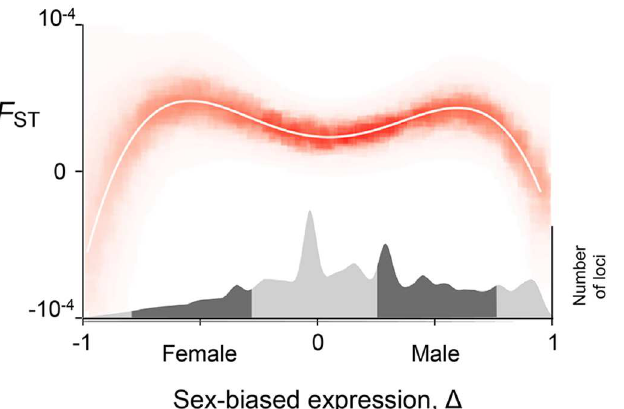
Fig 1. The strengthof sex-specific selectionis strongest on humanautosomal geneswith intermediatesex-biasedexpression. The white curve is the best-fit4 th degree polynomial and the intensity of red indicatesthe likelihood that the regression passes througha given value. The average F ST for the SNPs in a gene is small at Δ = 0 (unbiased expression), increasesto a peak as sex-bias grows, then decreases as Δ approaches–1 and 1. The numbers of genes with a given bias are visualized in the density plot in the lower partof the figure;darkgray denotesintermediate sex-biased expression.